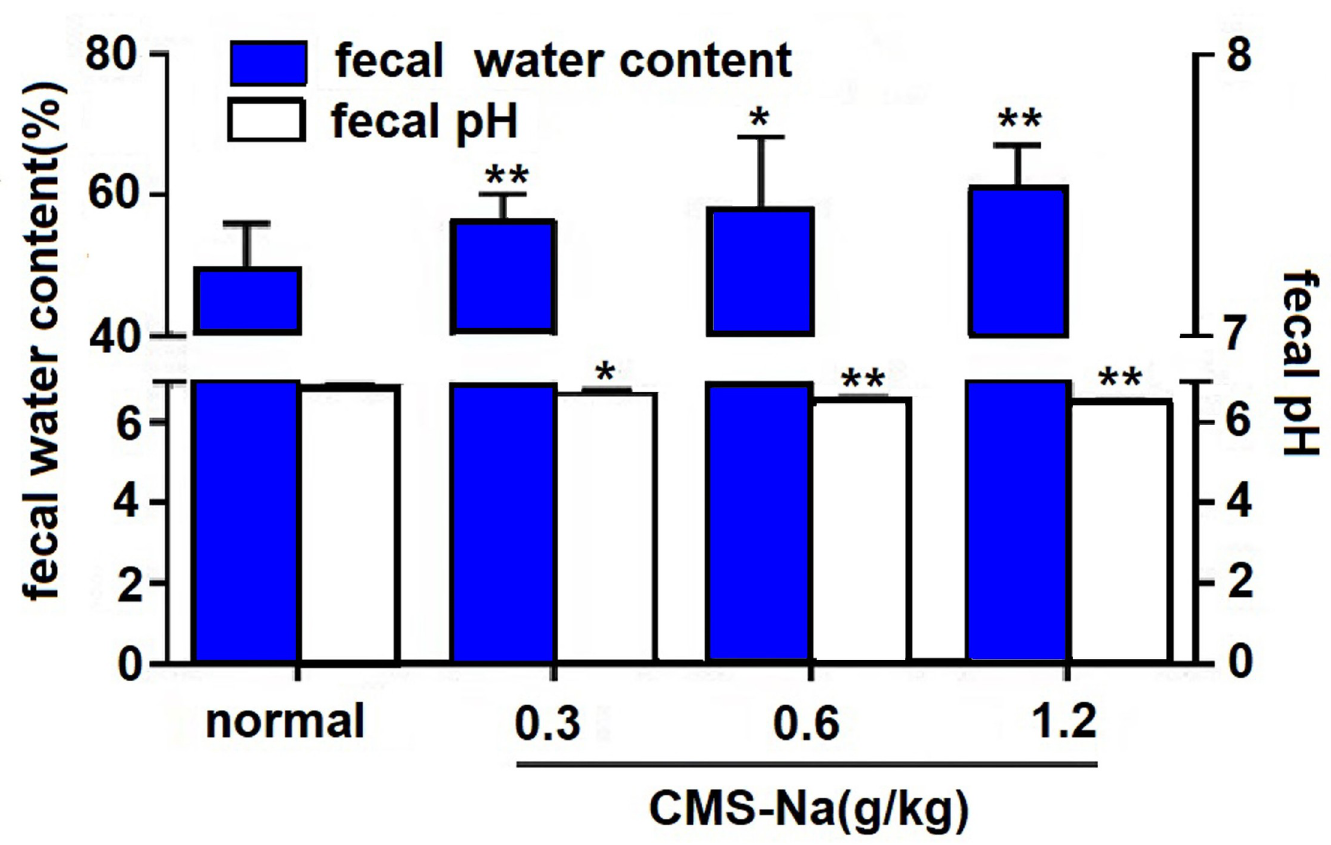
Fig 4. Effect of CMS-Na on the fecal water content and fecal pH of rats. Rats were orally treated with 0.3, 0.6, or 1.2 g � kg -1 CMS-Na once a day for 7 d. Then, approximately 200 mg feces was collected and the pH was measured. Mean ± SD, n = 10, � P < 0.05, �� P < 0.01, vs. normal.